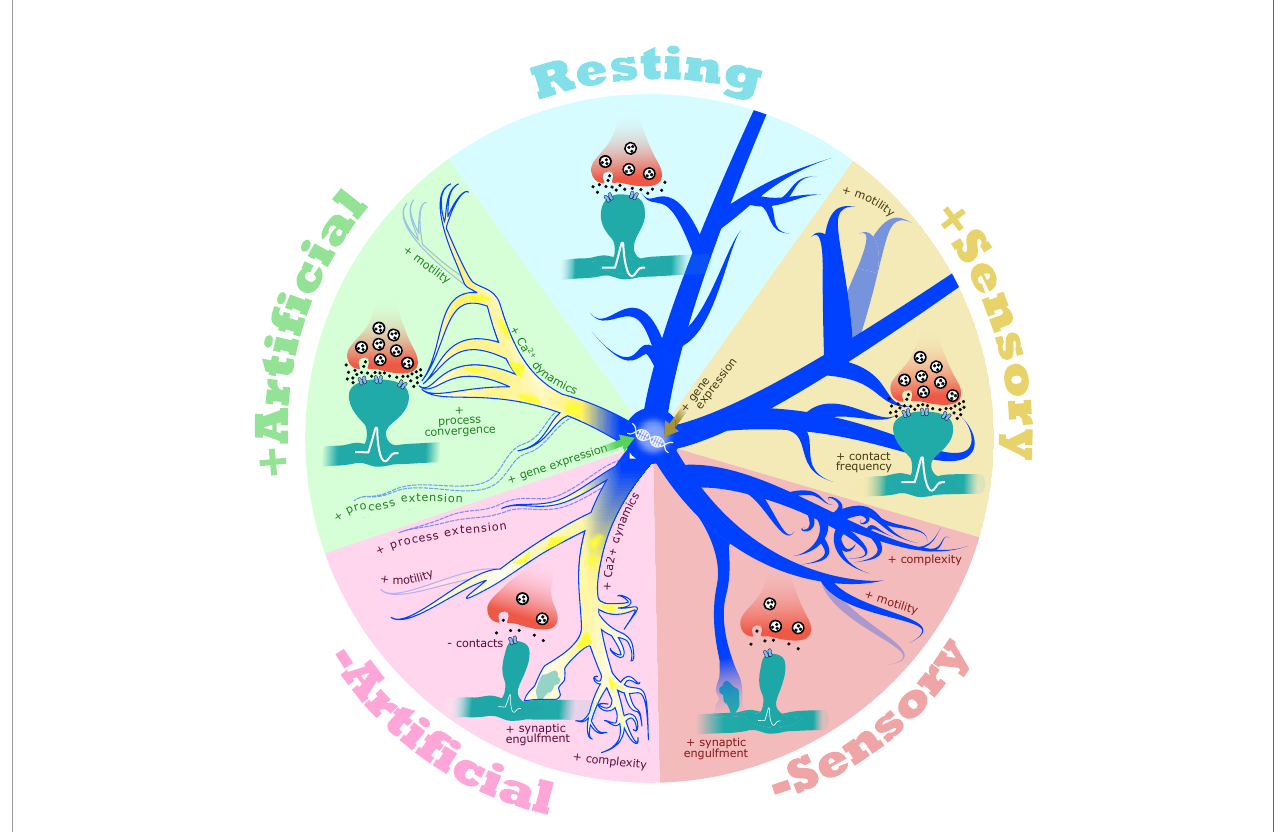
FIGURE 1 | Microglia respond to changes in neural activity. In a resting state, microglia (blue) actively survey the neural environment, dynamically contacting synapses (presynaptic terminals in red, postsynaptic dendrites and spines in teal). Arti fi cial manipulation of neural activity by pharmacological, chemogenetic, or optogenetic perturbation leads to robust changes in microglial calcium dynamics (shown in yellow), process motility, synaptic contact frequency, and transcription. Depriving mice of or exposing mice to sensory stimuli affect many of the same aspects of microglial function. These data are consistent with an important role for microglia in establishing and/or maintaining circuit stability and